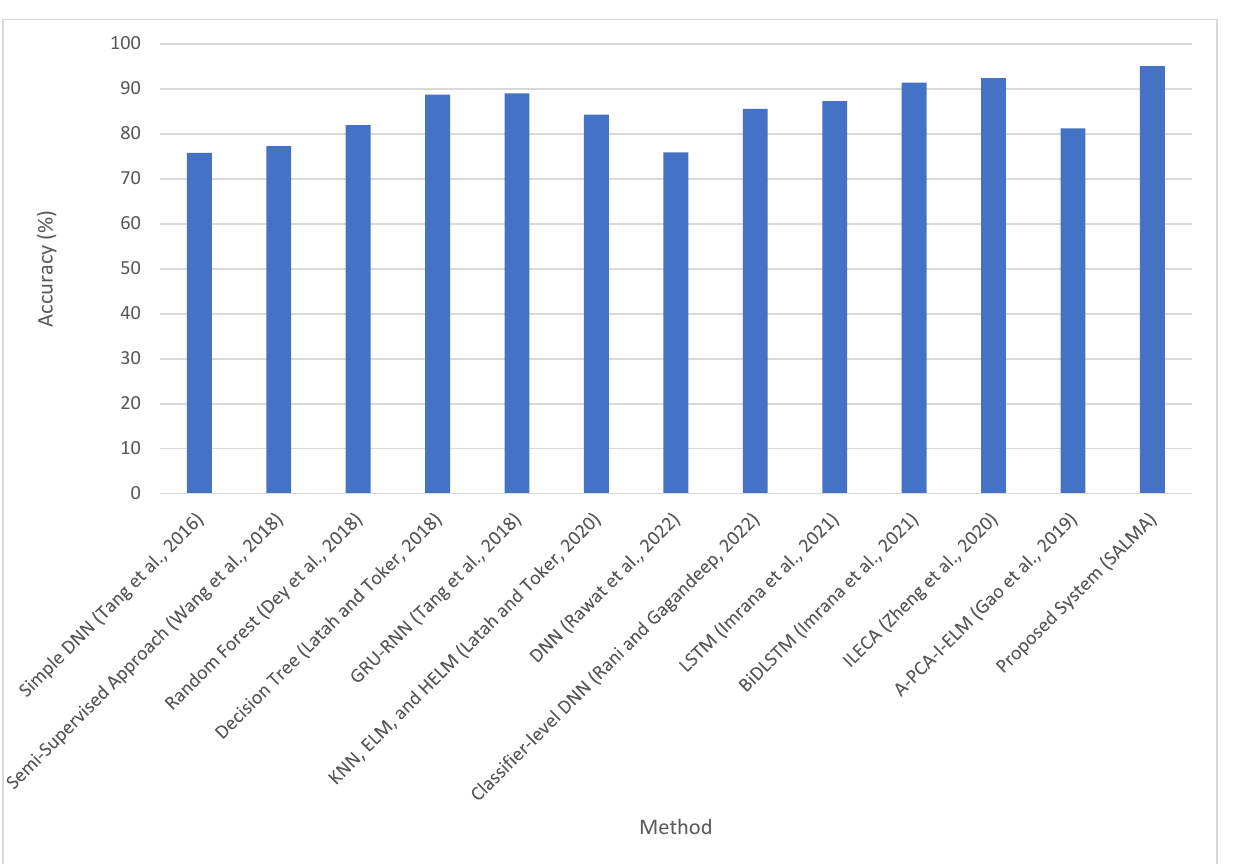
Table 8. Comparison between the proposed system and previous approaches on the KDDCUP99 dataset.